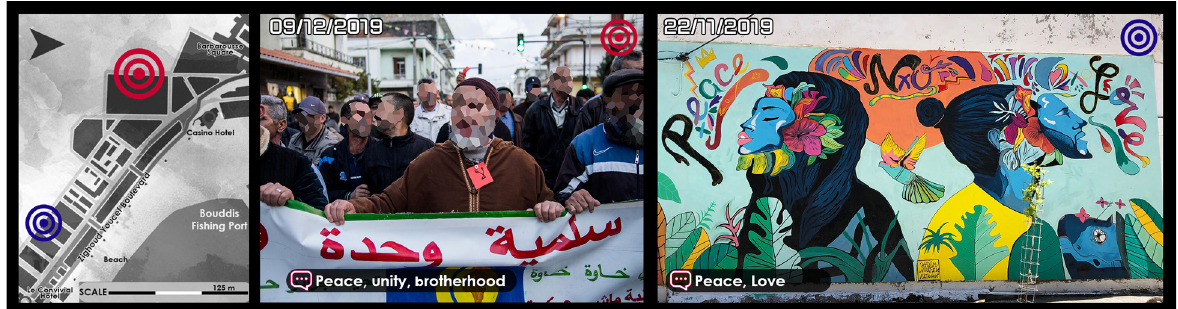
Fig. 5. Pictorial constructions of existential distinctions. From left to right: situation at boulevard Zighoud Youcef (Source: own study), political demonstration chanting peace, unity, brotherhood (Chemcham 2019b), and murals on the themes of peace and